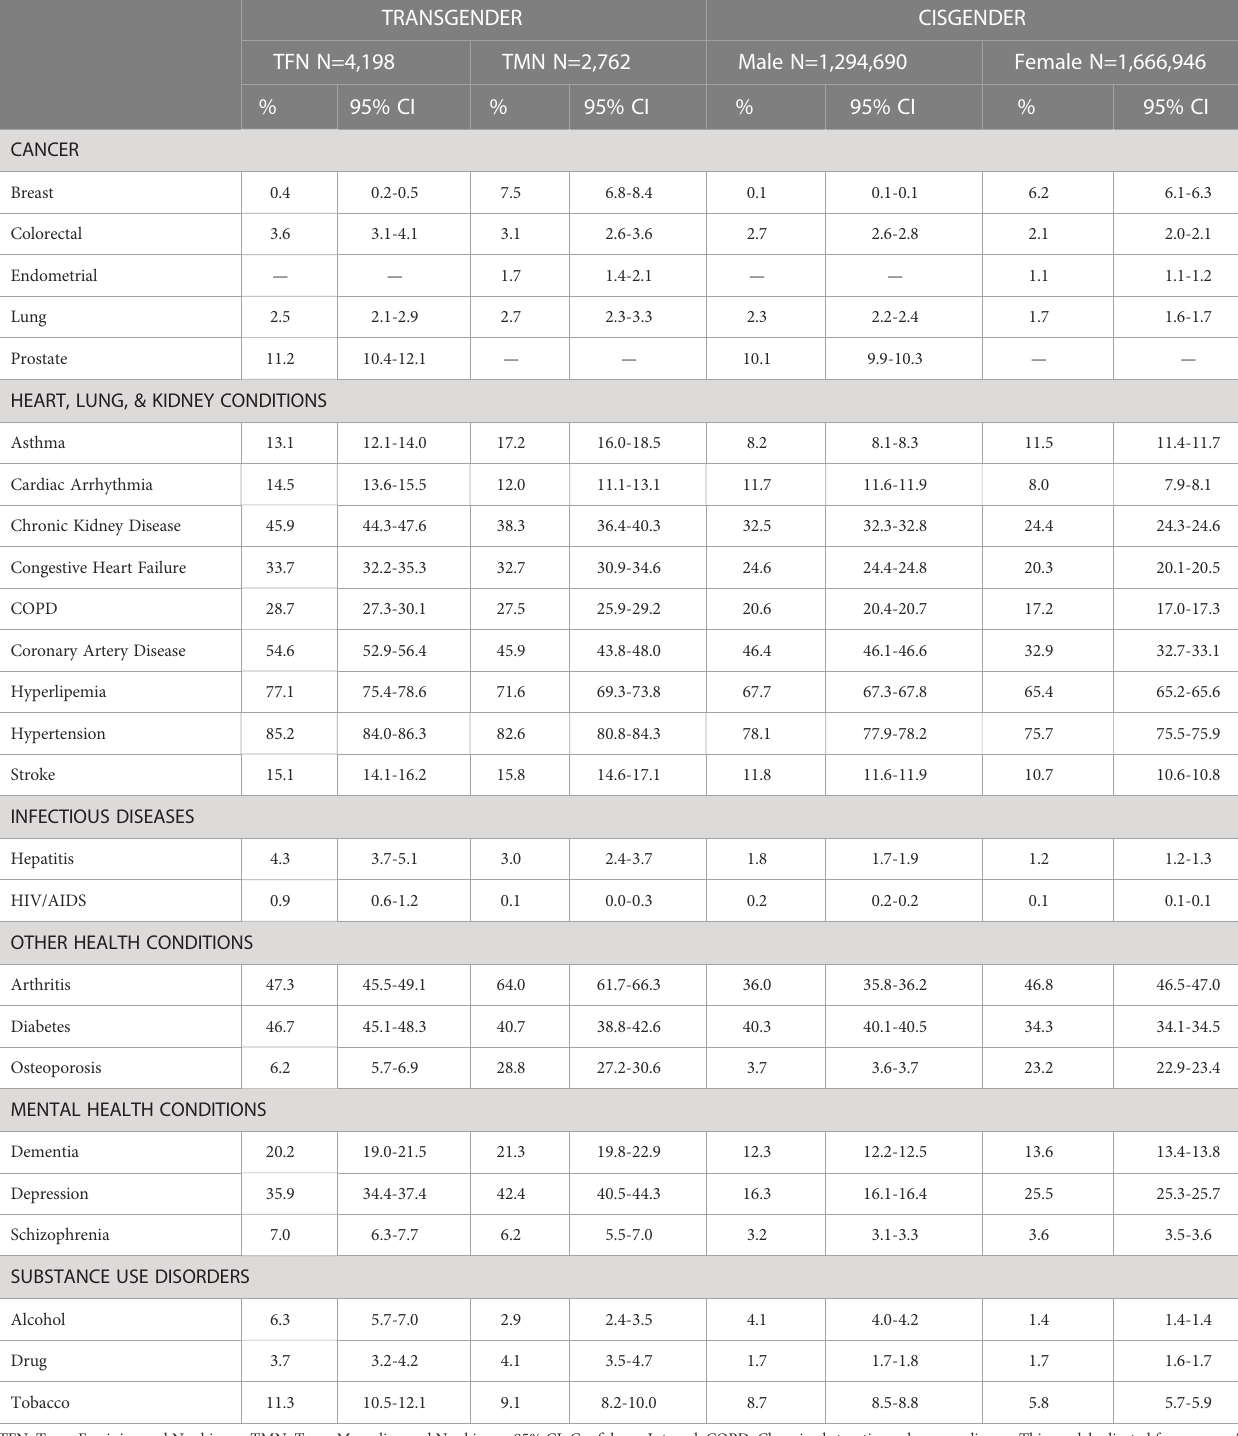
TABLE 2 Adjusted predicted probabilities of health condition diagnoses strati fi ed by inferred gender among age-entitled transgender and cisgender Medicare bene fi ciaries, 2008-2017.